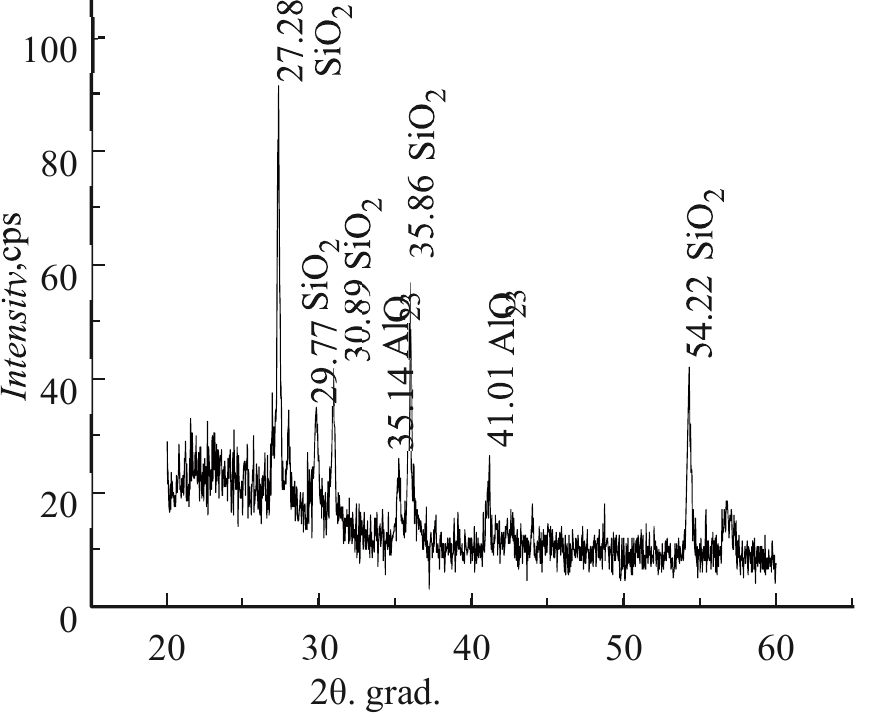
Figure 12. X-ray diffraction pattern of a pure glass crystal with an indication of the X-ray scattering angles 2 θ in degrees and substances above each diffraction peak [34].